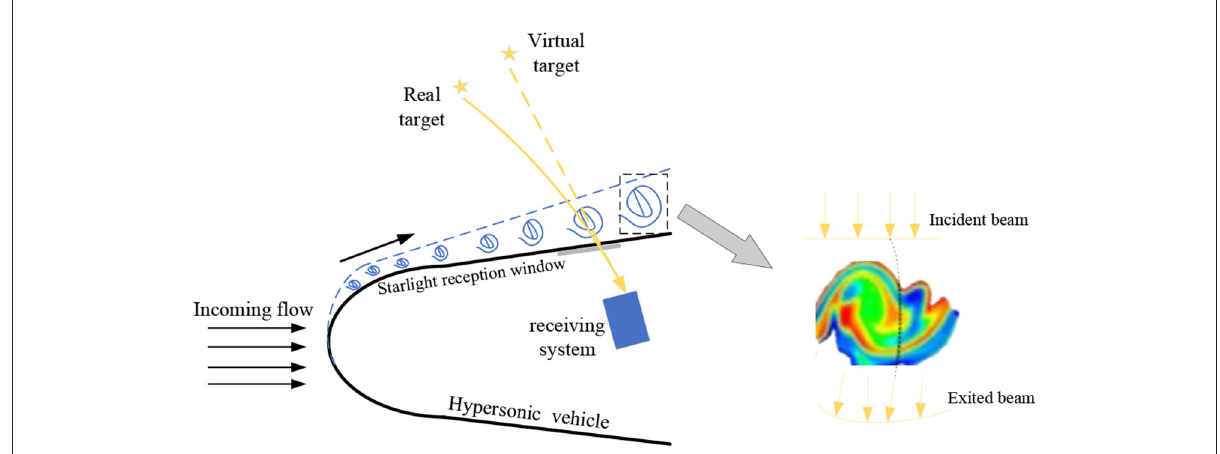
FIGURE1 Schematic diagram of the influence of aero optical effects on starlight atmospheric refraction